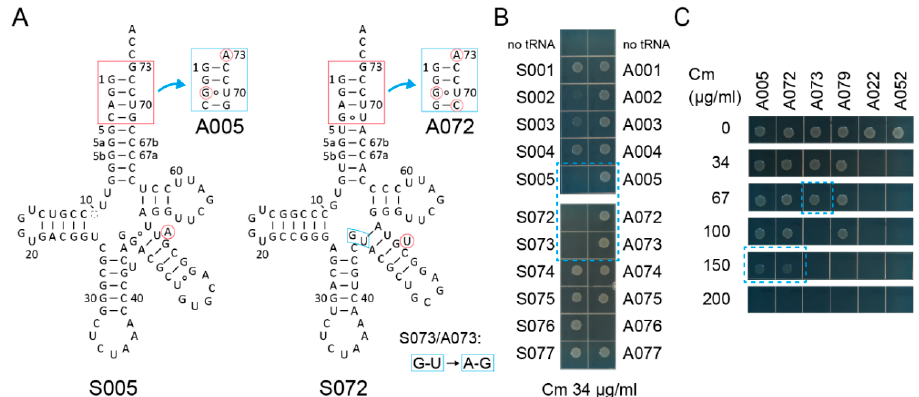
Figure 2. Candidate tRNA chassis. ( A ) The cloverleaf structures of the S005 and S072 tRNA variants